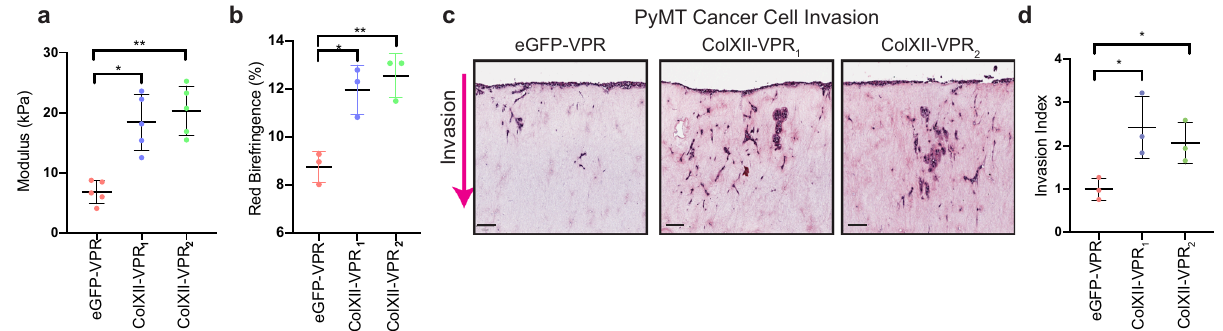
Fig. 7 | Collagen XII overexpression increases tumour stiffness and cancer cell invasion. a Bulk modulus (stiffness) of organotypic matrices at day 12 remodelled by control (eGFP-VPR) or collagen XII overexpressing (ColXII-VPR 1 , ColXII-VPR 2 ) CAFs as measured by uncon fi ned compression analysis. Mean±SD, n =5 biologi- cally independent experiments, * p =0.032, ** p =0.0075, Kruskal – Wallis test with Dunn ’ s multiple comparison test. b Quanti fi cation of the red birefringence signal area for picrosirius-red-stained organotypic matrices generated by control (eGFP- VPR) or collagen XII overexpressing (ColXII-VPR 1 , ColXII-VPR 2 ) CAFs. Mean±SD, n =3 biologically independent experiments, * p =0.034, ** p =0.0078, one-way ANOVA with a Dunnett ’ s multiple comparisons test. c Representative histological